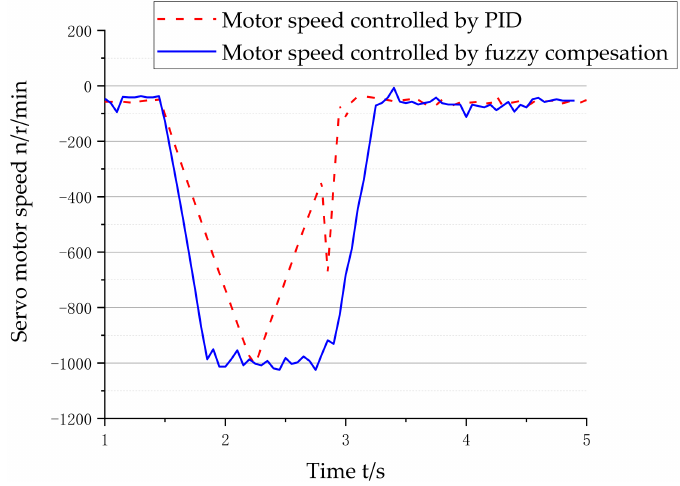
Figure 13. Speed response curve of the servo